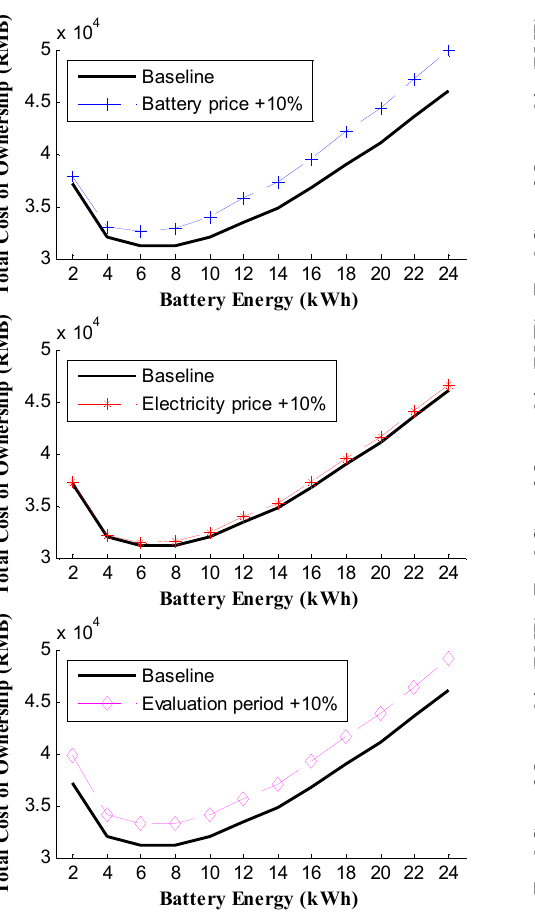
Figure 7. The sensitivity